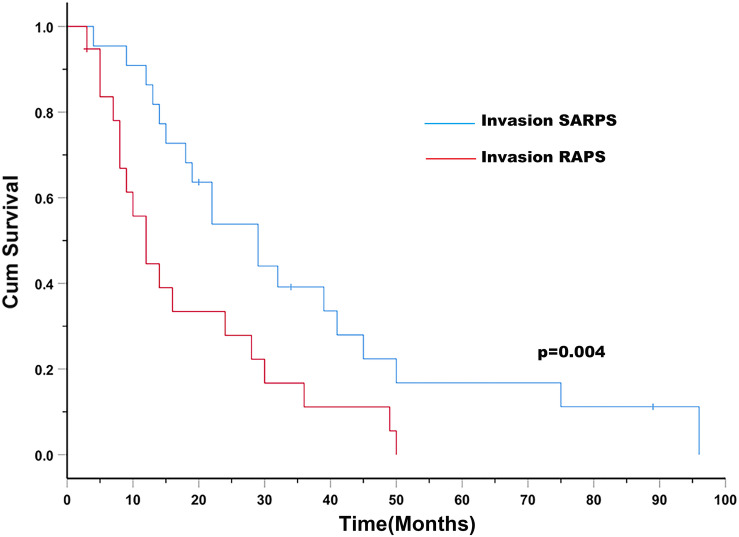
Patients with HCC with SARPS invasion (blue line) have an increased survival rate compared to those with HCC with RAPS invasion (red line; P = 0.004). Abbreviations: SARPS, superior aspect of the right perirenal space; RAPS, right anterior pararenal space.